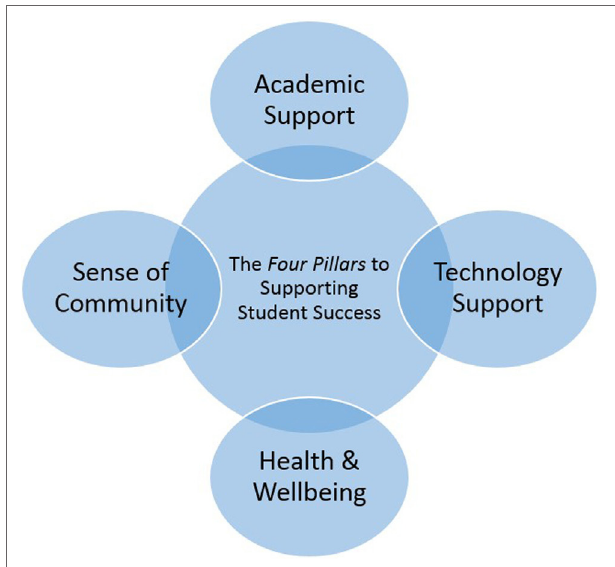
FiGuRe 3 | The “four pillars” to supporting student